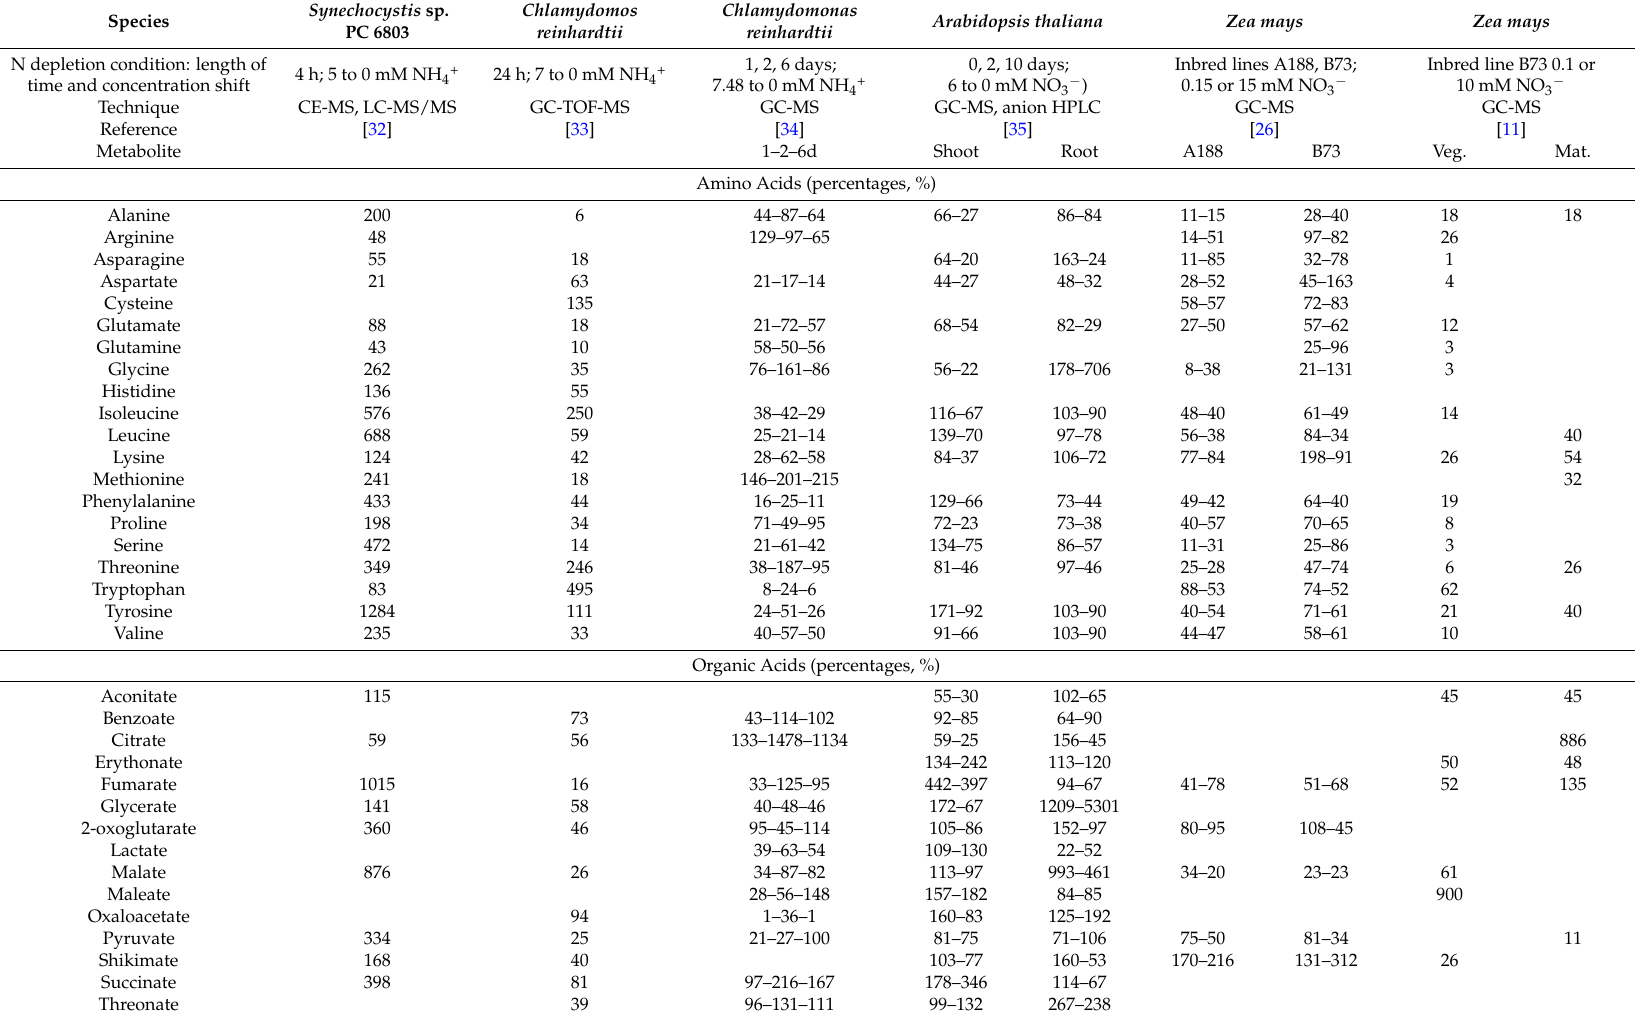
Table 1. Effect of nitrogen starvation on the metabolome of